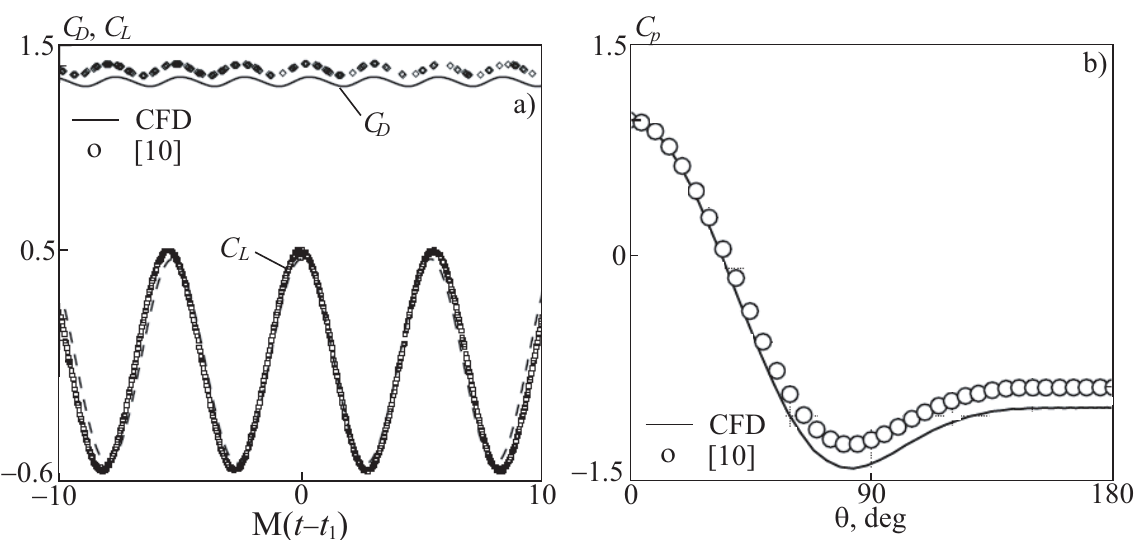
Figure 4. Changes in the lift coefficient (dashed line) and drag coefficient (solid line) over time ( a ), and the distribution of the average pressure coefficient over the cylinder surface ( b ) for Re = 150. The characteristics of the flow in regime 1 are in good agreement with the available numerical and experimental data (Table 1, where C pb , C L , and C D are the mean pressure coefficient, the mean square lift coefficient, and the mean drag coefficient). In particular, in calculations the Strouhal number is 0.186, while the data of a physical experiment give a value of 0.184 [8] and 0.183 [12]. The angular coordinate of the flow separation point is θ s = 108.5 ◦ . Averaging is carried out over a time interval equal to 150. To find the Strouhal number, the correlation relation St = 0.2684 − 1.0356Re − 1/2 from [15] is used. The Strouhal number equals St = 0.1838 for Re = 150, which is in good agreement with the obtained value. The results of calculations of the Strouhal number in comparison with experimental data are shown in Figure 5.